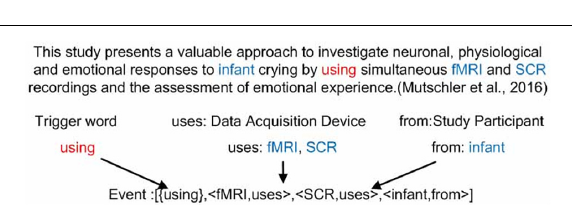
“+” indicates that the element may occur one or more